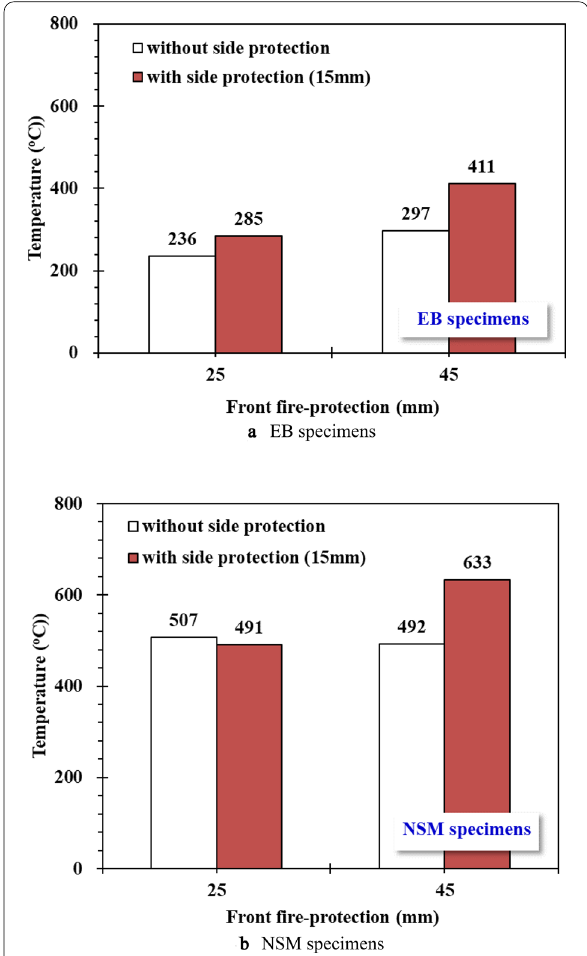
Fig. 14 Comparison of bond‑failed temperatures with or without sides